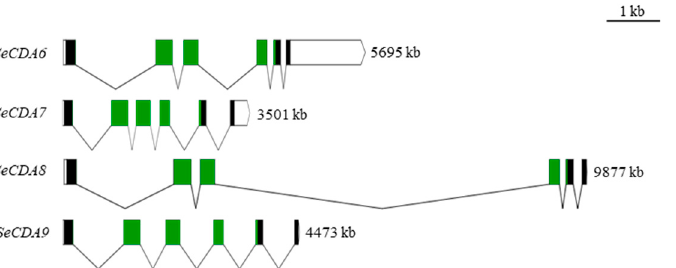
Figure 1. Schematic diagram of exon–intron of SeCDAs gene and domain of SeCDAs amino acid. The structure of the genome sequence is plotted to scale. Exons are represented by solid rectangles, noncoding regions are represented by hollow rectangles, and the connecting line between two exons represents introns. The green rectangles represent the chitin deacetylation catalytic domain.